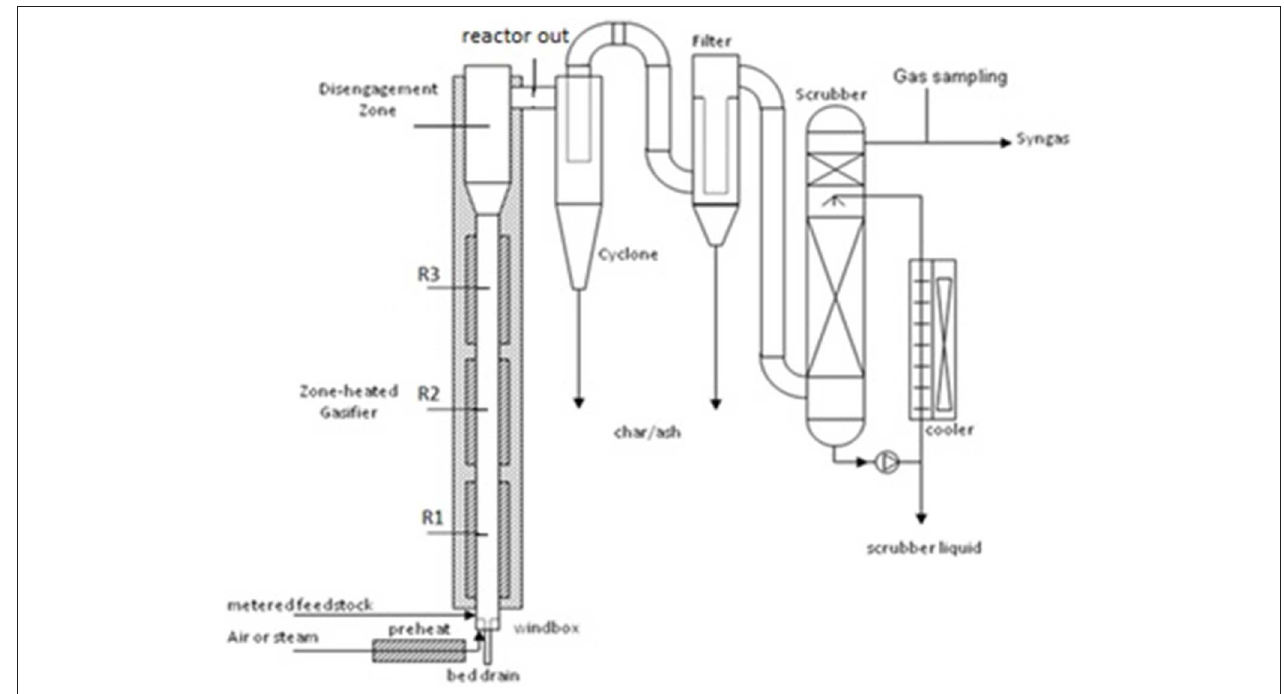
FIGURE 1 | Schematic illustration of laboratory reactor with thermocouple locations for R1, R2, R3, disengagement zone, and reactor outlet.